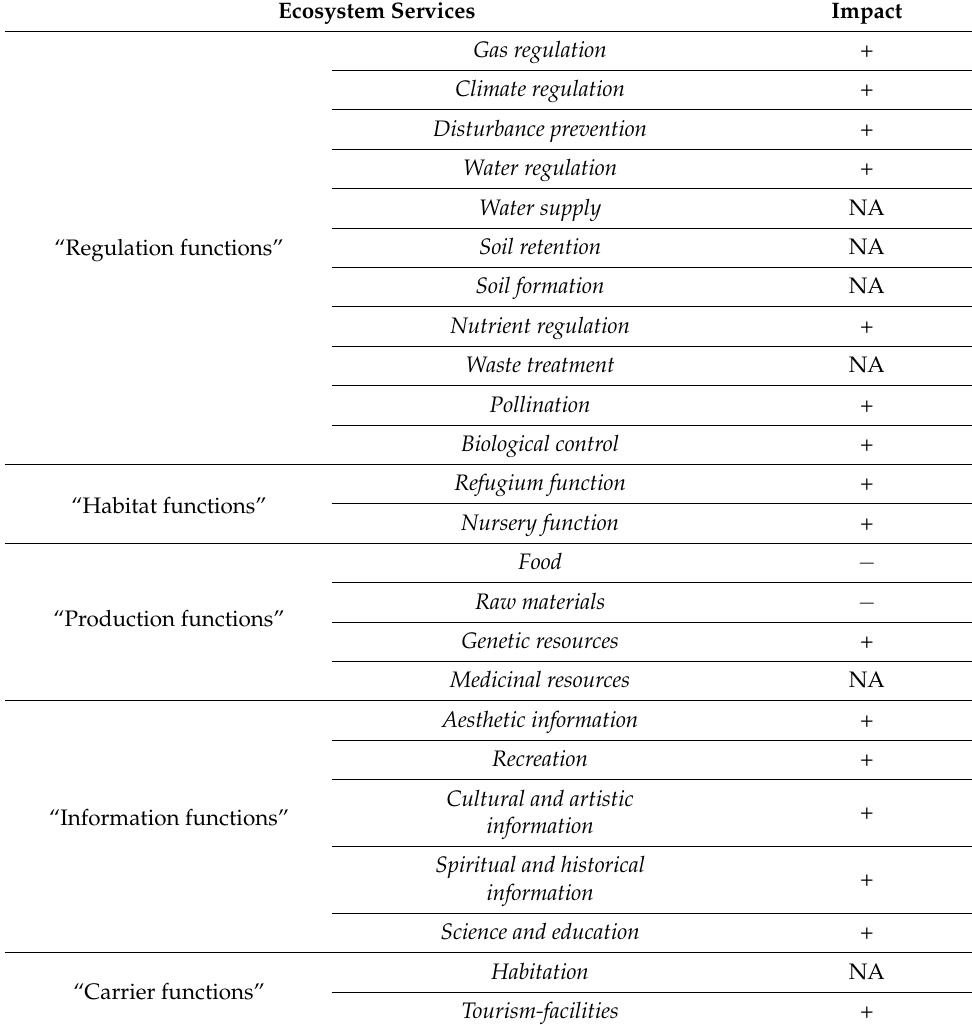
Table 4. Summary of qualitative ecosystem services impacts passing from arable lands to forest